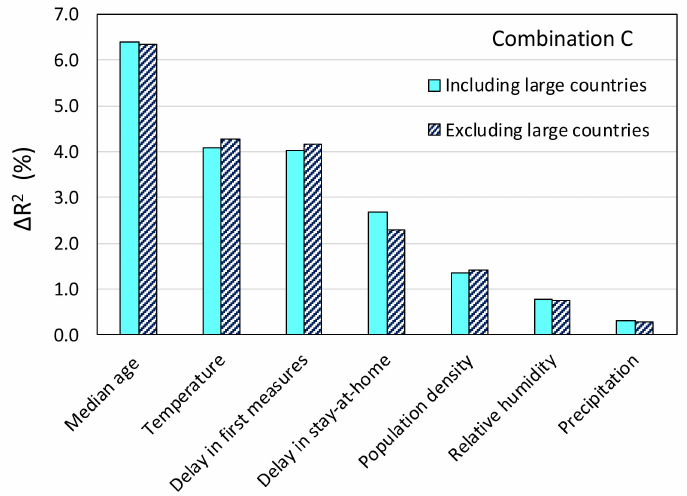
Figure 18. E ff ect of excluding large countries on the importance rank of causal variables resulting from stepwise